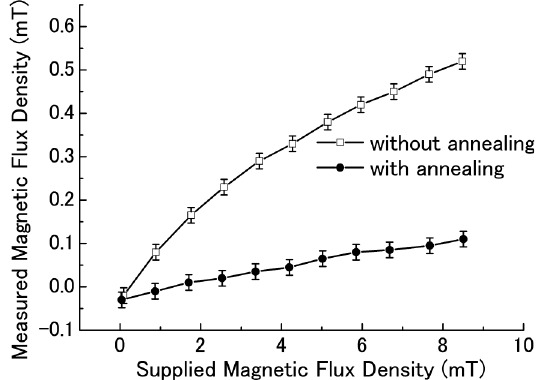
FIG. 5. Annealing effect of the SUS430. The horizontal axis represents the supplied magnetic flux density from Helmholtz coils, and the vertical axis represents the magnetic flux density measured with a Hall device